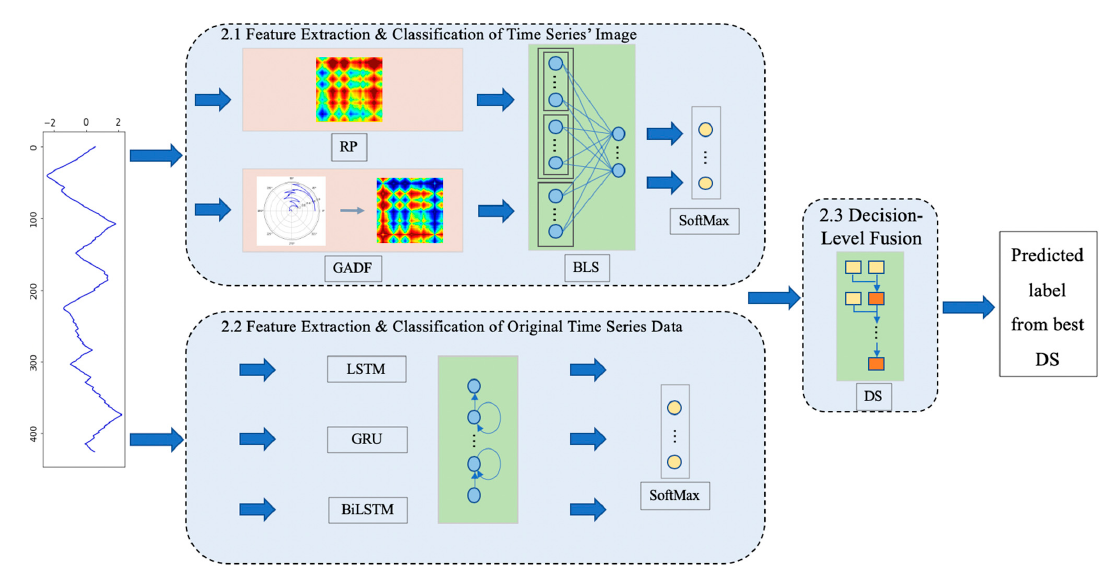
Figure 1. Framework. Figure 1.